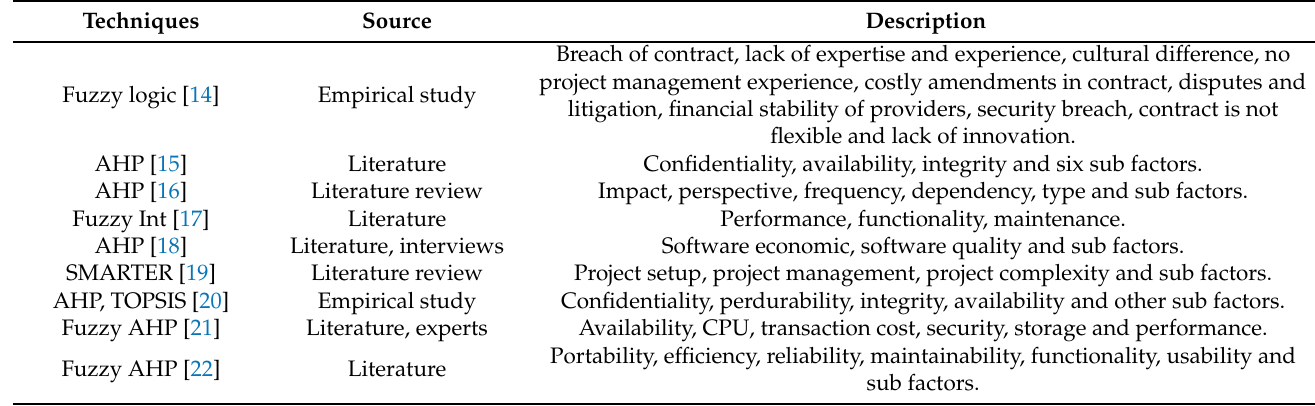
Table 1. Summary of the study